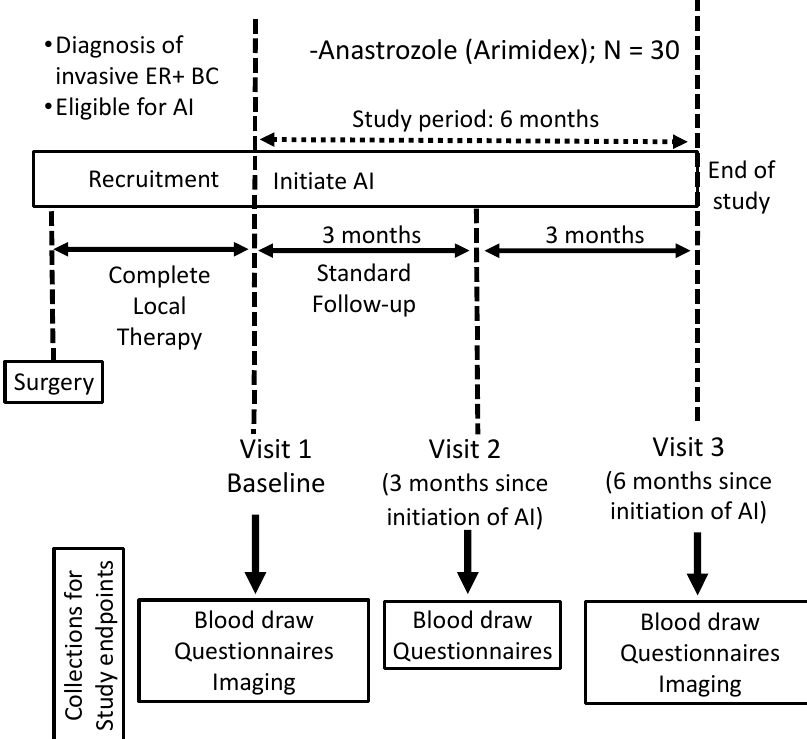
Figure 1. Clinical trial study design. Abbreviations. AI: Aromatase Inhibitor; BC: Breast Cancer; ER+: Estrogen Receptor Positive.